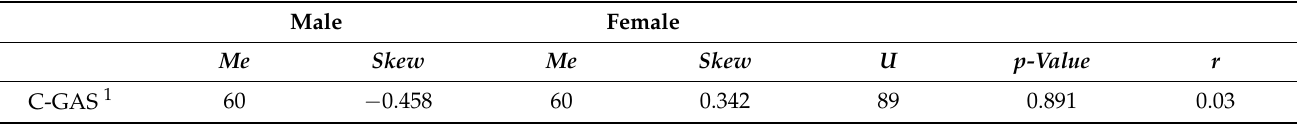
Table 5. Differences in CGAS scores in Middle childhood.